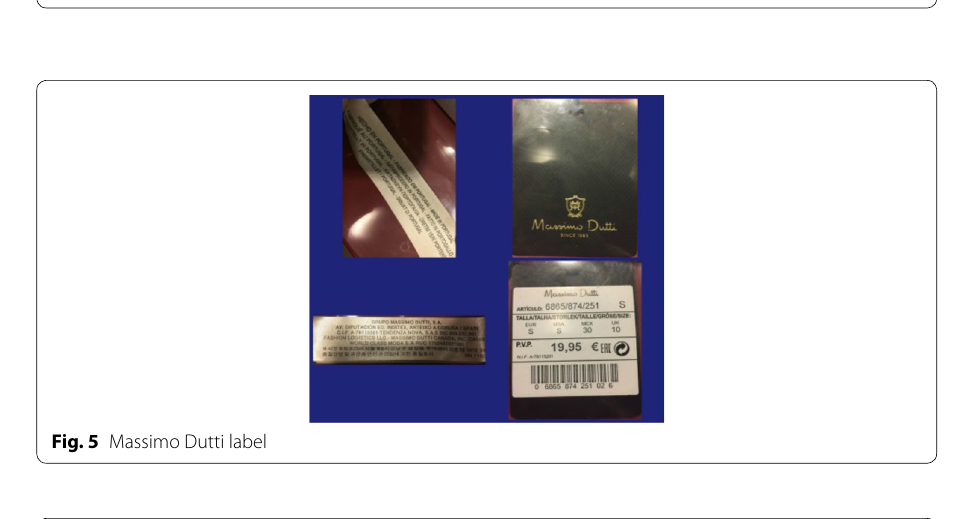
Fig. 4 Ruval label